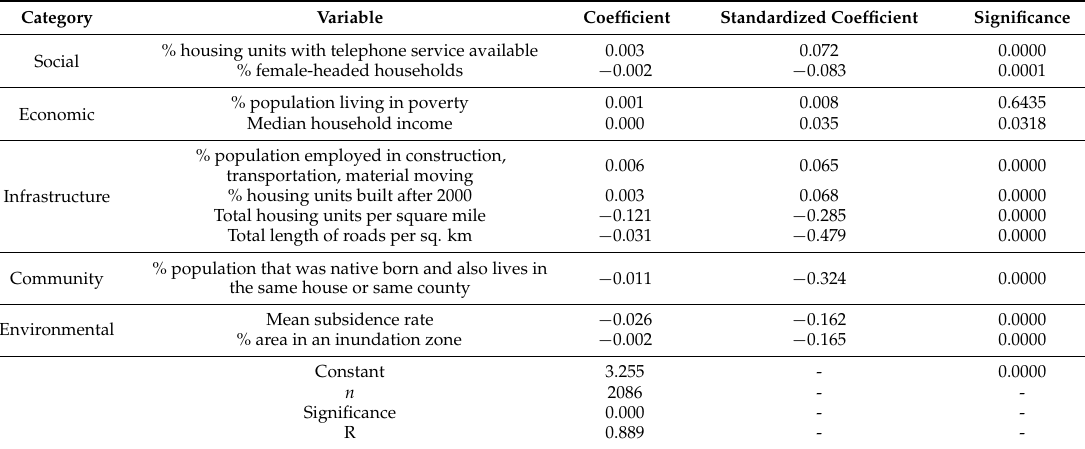
Table 4. Regression results of all variables with continuous